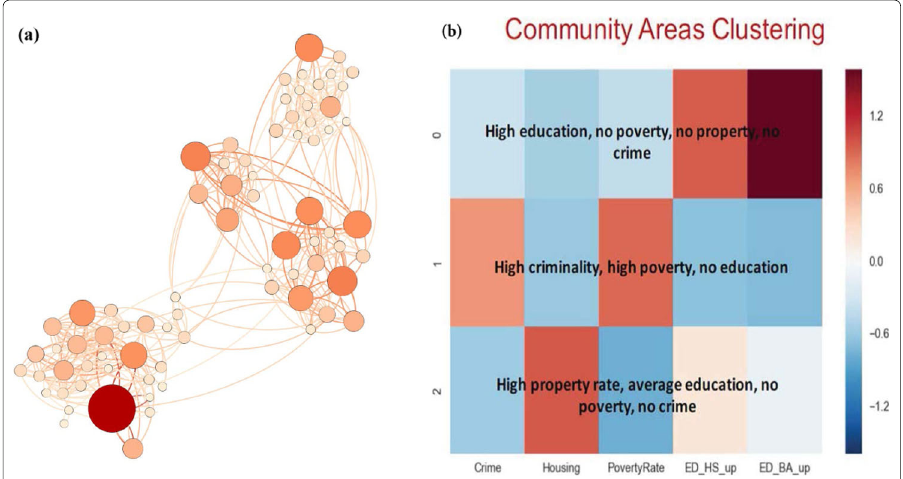
Fig. 1 Network of Chicago 77 communities. ( a ) Community graph for year 2017. There are 77 nodes representing communities and 204 edges connecting a pair of communities sharing a boundary with each other. The average degree is 5.3 and diameter 9. The entire network consists of one fully connected component. The darkness of color is proportional to the crime rate and size is proportional to population of each cluster. The clusters of high crime are clearly visible. ( b ) Three clusters of communities. Each cluster contains communities with the same range of values for three features: level of poverty, percentage of property ownership, and level of